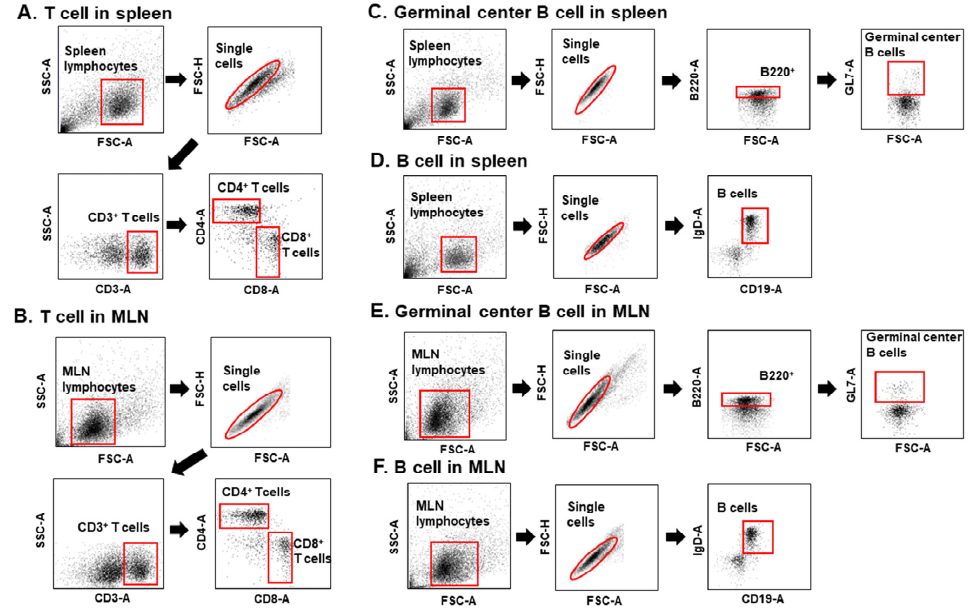
Figure 3. The gating strategy of CD4 + T cells, CD8 + T cells, and B cells in spleen and mesenteric lymph nodes (MLNs). Spleen and MLN cells from mice ( n = 6) were collected at 35 dpi upon challenge infection with T. gondii ME49 and stained with phenotype-specific antibodies (CD3, CD4, CD8, B220, and GL7). The gating strategies depicted above were applied to identify CD4 + and CD8 + T cells ( A , B ), germinal center B cells, and B cells from both spleen and MLNs ( C – F ).